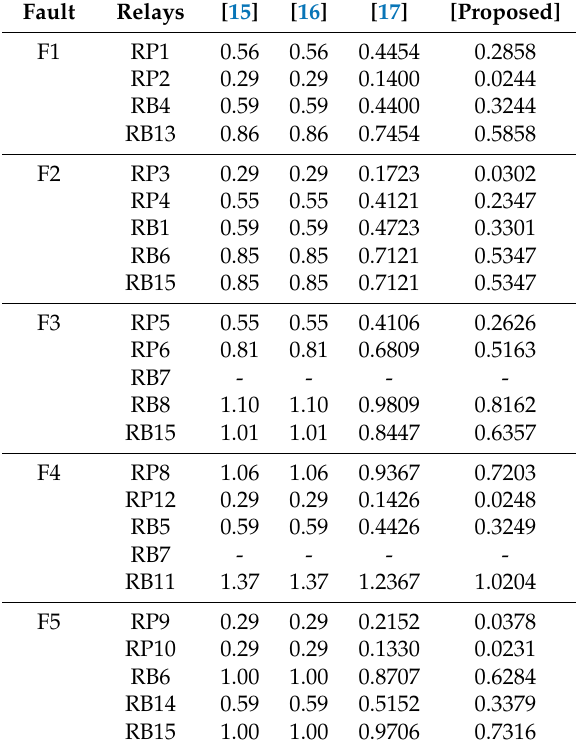
Table 11. Operation times for